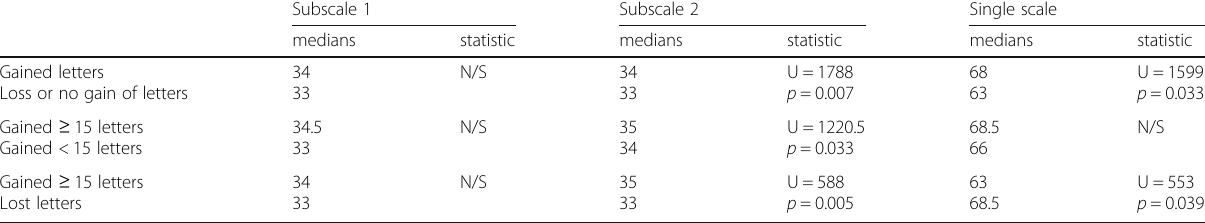
Table 7 Comparison of MacTSQ scores amongst subgroups with gain or loss of letters at 12